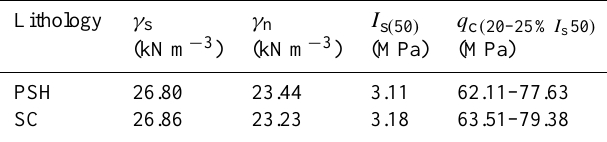
Table 2. Physical and mechanical properties of the intact PSH and SC rock based on laboratory tests. γ s – solid weight of unit volume; γ n – weight of unit volume; I s ( 50 ) point load index (ASTM D5731-